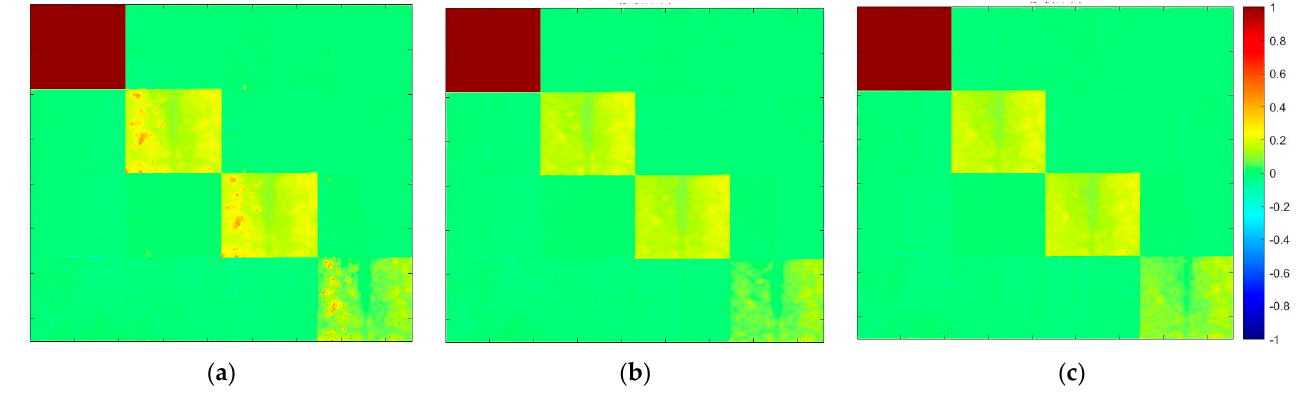
Figure 6. Images of Mueller matrices of double-layer tissue consisting of porcine skin and adipose layer in one-hour experimental time: ( a ) 8, ( b ) 25, ( c ) 58 min. Among the 16 matrix element images of the three MM images, the left half represents tissue with application of 10% glycerin and the right half represents the control group.